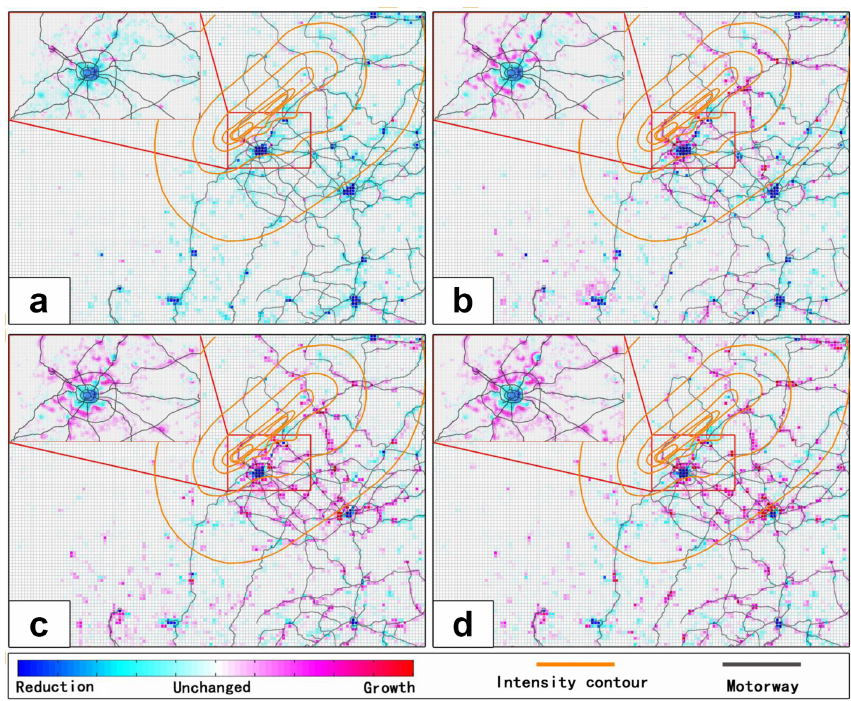
Figure 15. Economic recovery process in the disaster area: (a) economic recovery area in 2009, (b) economic recovery area in 2010, (c) economic recovery area in 2011, (d) economic recovery area in